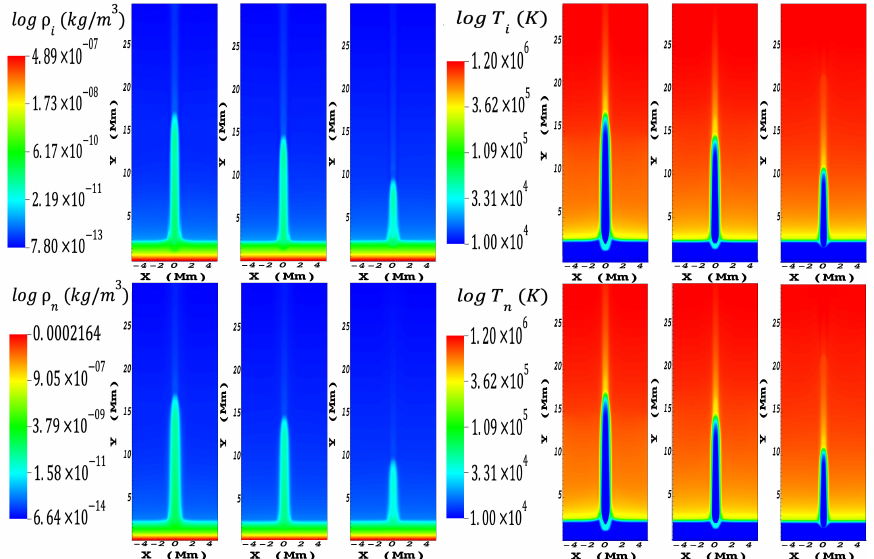
Figure 3. Uniform magnetic field case. Left : maximum heights reached by the jets generated at y 0 = 1.3 (Jet1), 1.5 (Jet2), and 1.8 Mm (Jet3), at t = 300 s, t = 270 s, and t = 210 s, respectively (left to right). Temporal evolution of log ρ i , n ( x , y ) is shown for ion ( upper ) and neutral ( lower ) densities. Right : temperatures reached by the jets Jet1, Jet2, and Jet3 generated at t = 300 s, t = 270 s, and t = 210 s, respectively (left to right). Temporal evolution is shown for log T i , n ( x , y ) for ions ( upper ) and neutrals ( lower